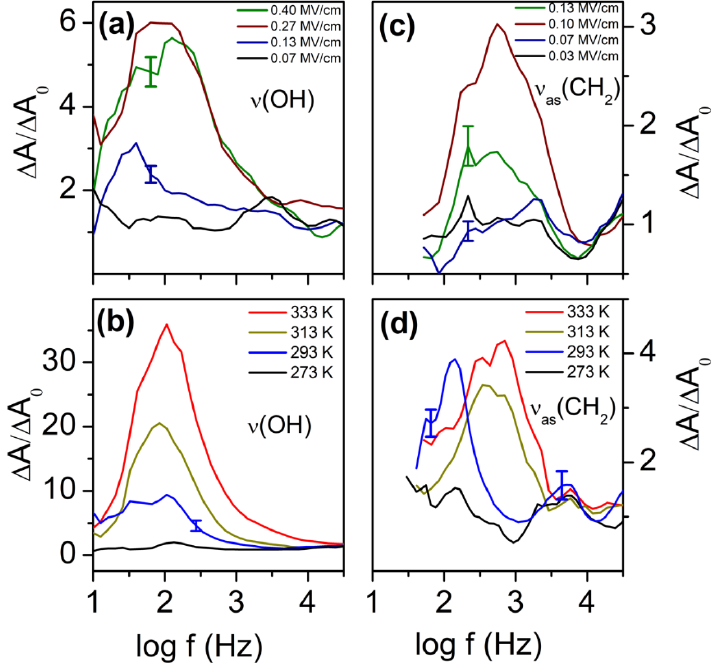
Figure 7. ( a ) Orientation polarization spectra ∆ A or ( ω ) / ∆ A 0 of the OH and CH 2 moieties as measured by the lock-in amplifier (in the second harmonic) at the wavelengths of 2966.8 nm (3370.6 cm − 1 ) and 3493 nm (2862.9 cm − 1 ): ( a , c ) show the field strength; ( b , d ) show the observed temperature dependencies. As spacer, a PET foil of ~3 µ m thickness was used. The result is an applied voltage of +/ − 120 V in an electric field strength ~+/ − 0.4 MV/cm with a large uncertainty because the absolute sample thickness cannot be measured with sub- µ m precision. Within one figure, the sample thickness is assumed to remain nearly constant as confirmed by measurements of the